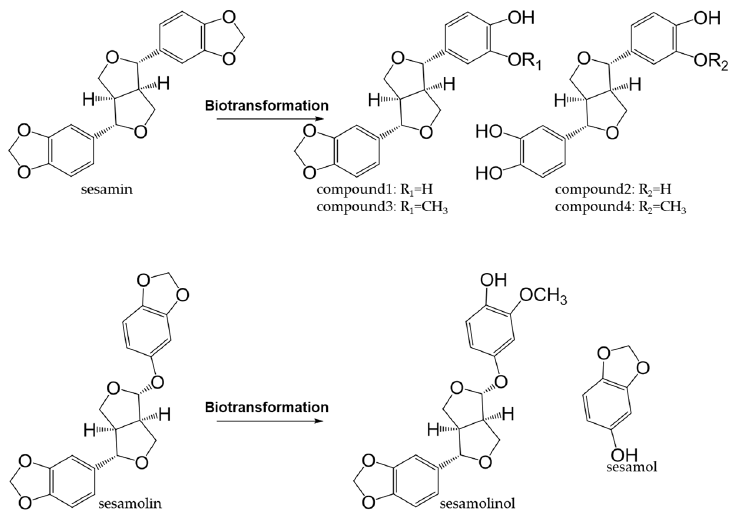
Figure 12. Biotransformation of sesamin and sesamolin.